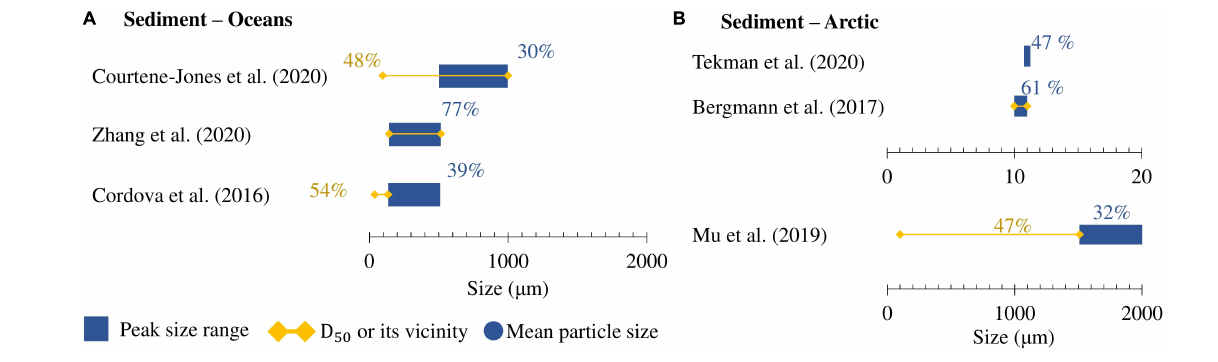
FIGURE 5 | Size distribution characteristics for sediment samples for (A) offshore and (B) the Arctic. The box in each study identifies the size bin with the highest concentration. The horizontal bar in each study is the D 50 , or its proximity. The circles are the average MP size presented by selected studies, where size distribution was available but could not be